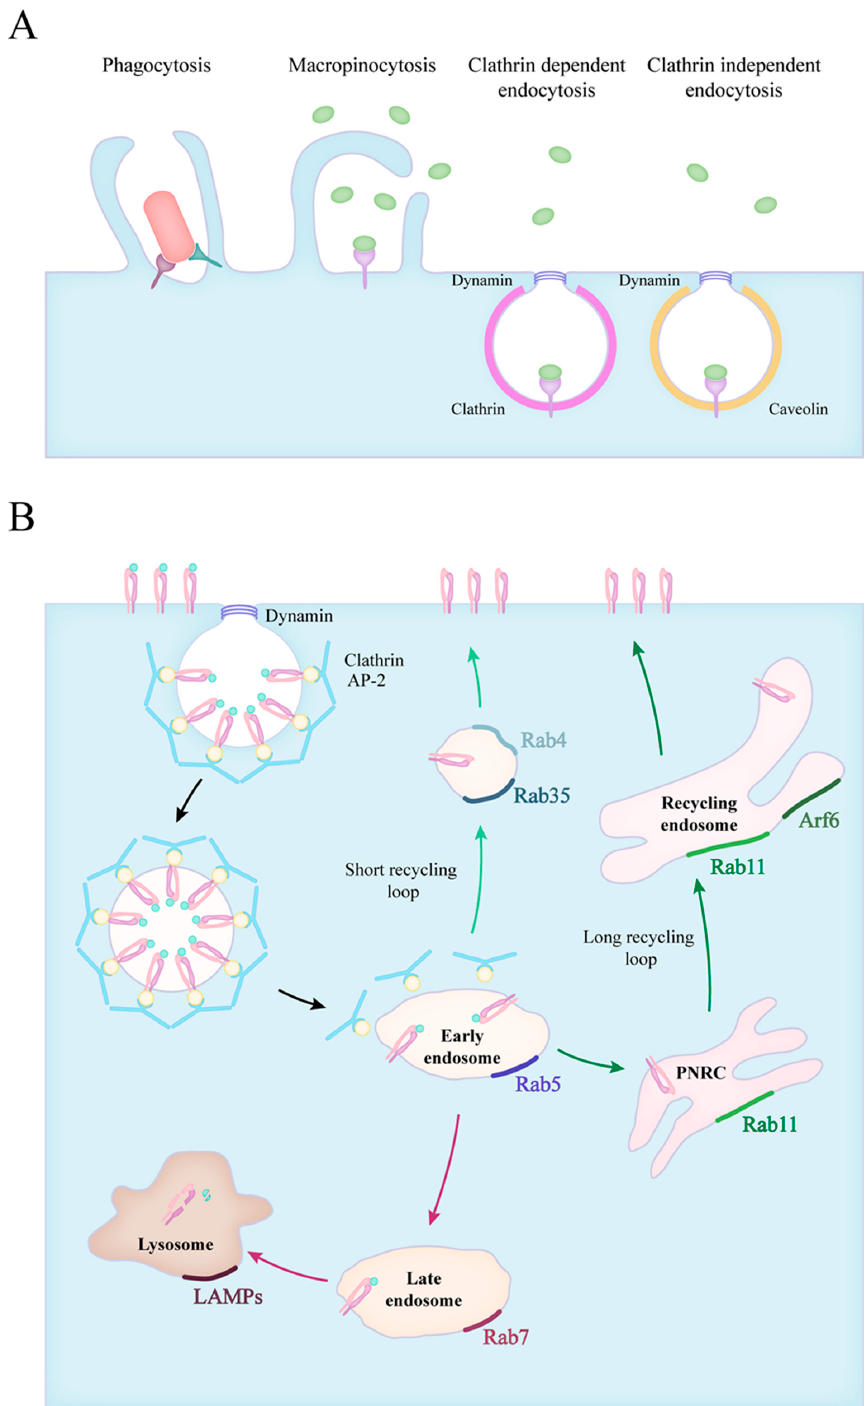
Figure 1. Forms of particle uptake and the endocytic routes. ( A ) The endocytic routes involve phagocytosis, macropinocytosis, clathrin mediated and clathrin independent endocytosis. ( B ) The fate of internalized particles is shown in the case of clathrin dependent endocytosis. Vesicles scissed from the plasma membrane quickly lose their clathrin coating and fuse with early endosomes (black arrows). Early endosomes transition into late endosomes, and in time, to lysosomes (red arrows). The recycling of receptors can occur via a short loop (green arrows), directly from early endosomes or through a long loop across the perinuclear recycling compartment (PNRC) and recycling endosomes (dark green arrows). The small GTPase Rab proteins characteristic for each stage are also indicated.